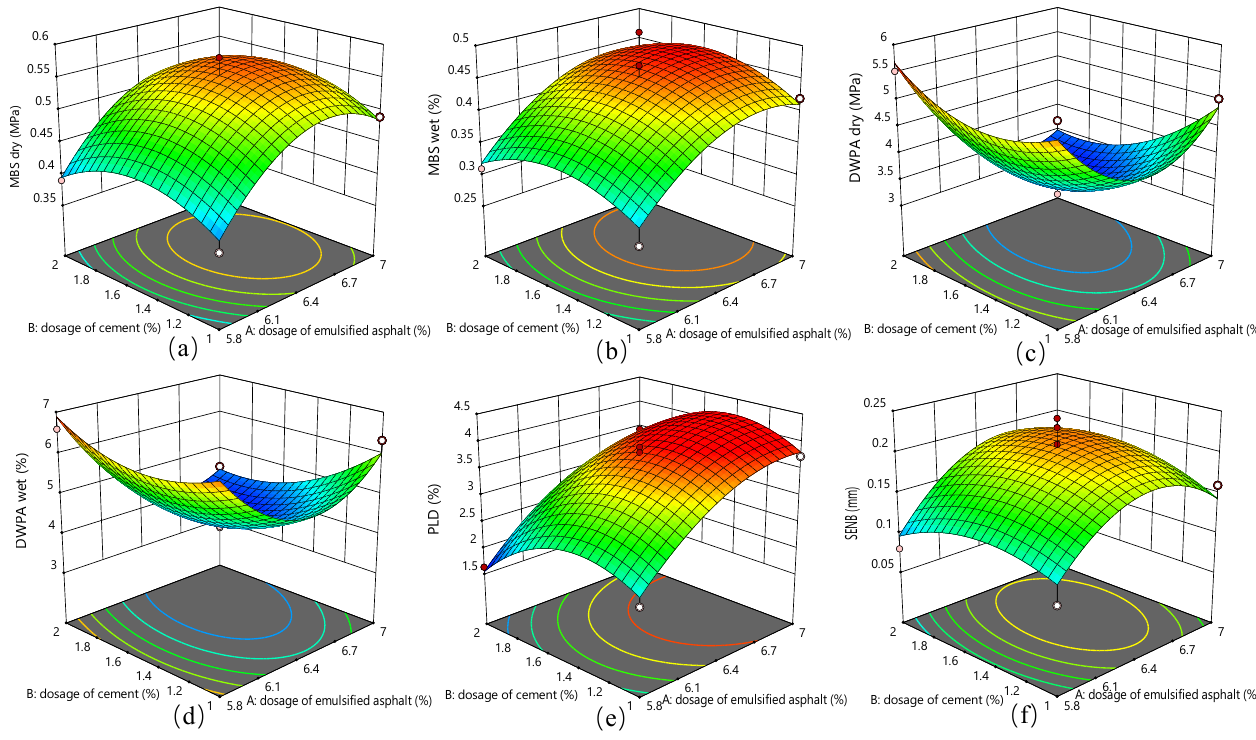
Figure 6. Effect of emulsified asphalt, cement, and temperature on the characteristics: ( a ) MBS dry , ( b ) MBS wet , ( c ) DWPA dry ,